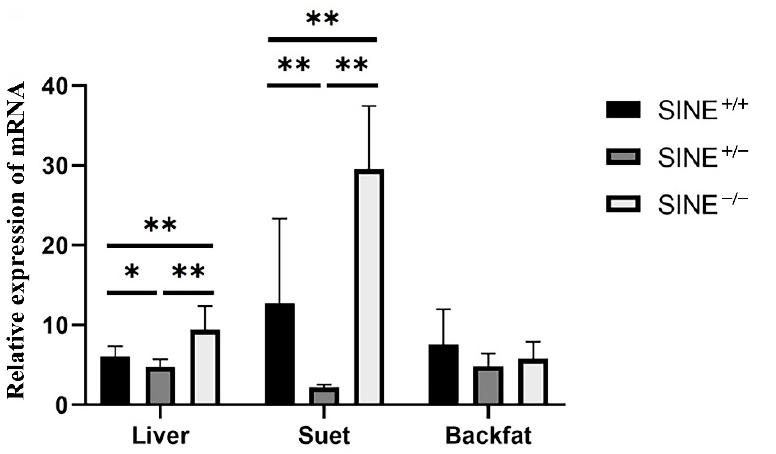
Figure 2. Relative expression of LEPROT gene in tissues of 30-day-old Sujiang piglets. * showed p < 0.05; ** showed p < 0.01.